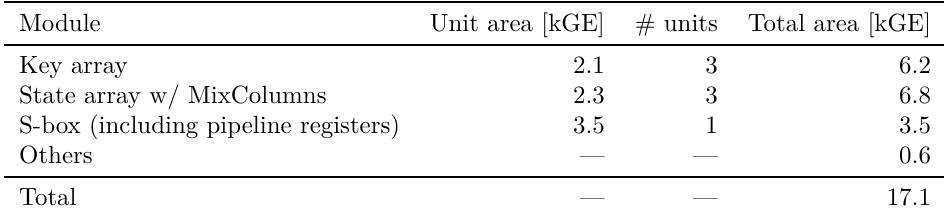
Table 4: Circuit-area breakdown of the proposed AES